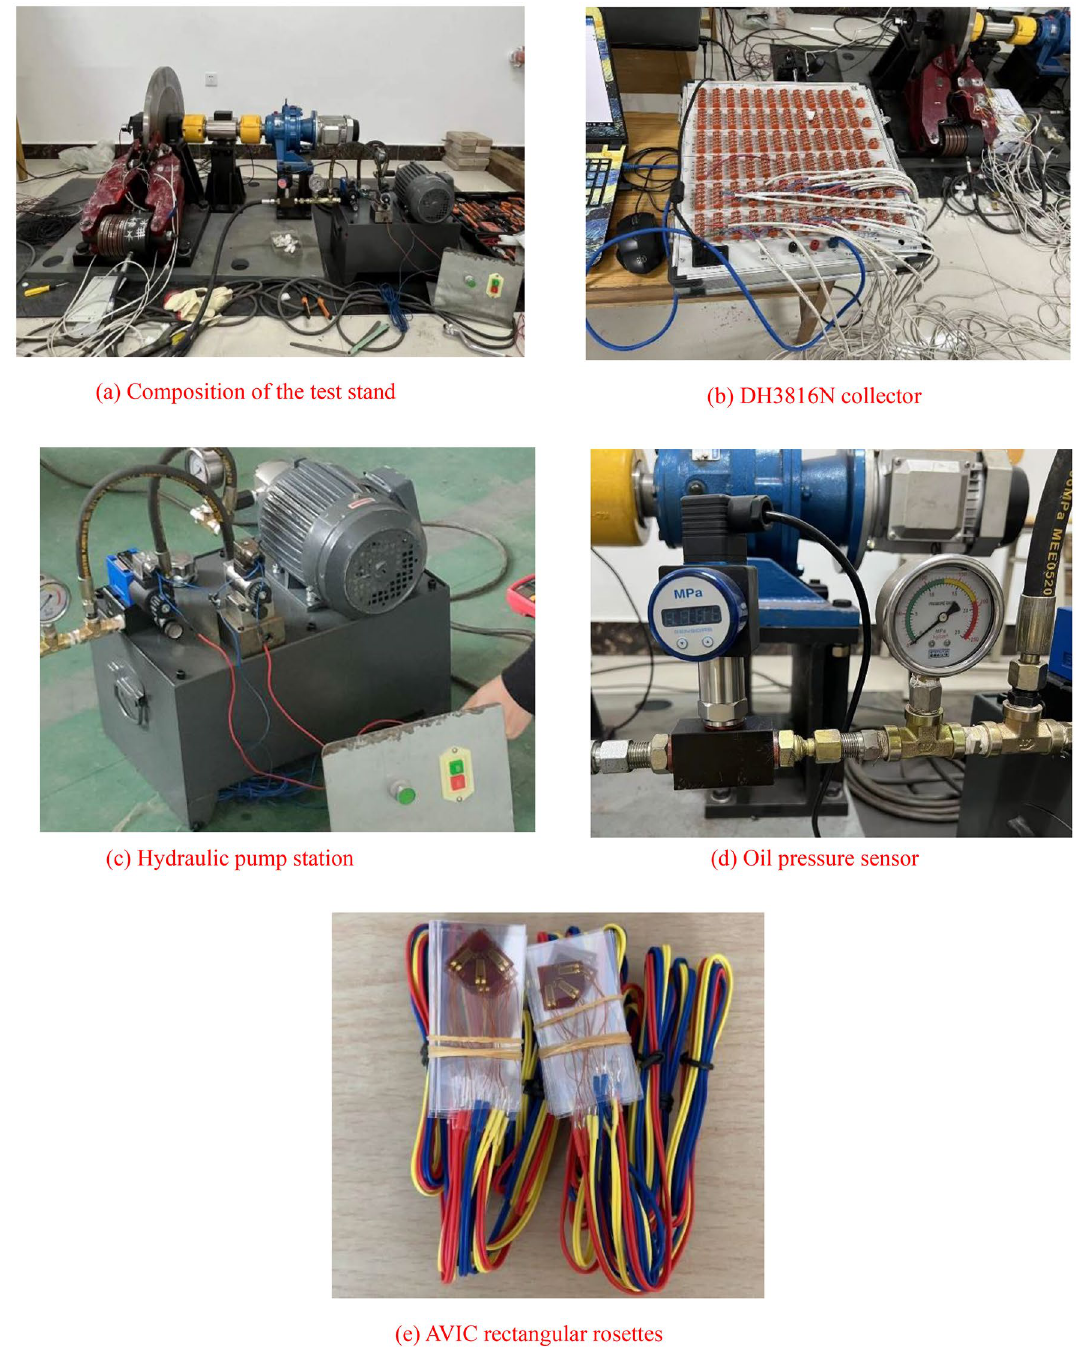
Figure 10. Diagram of experimental